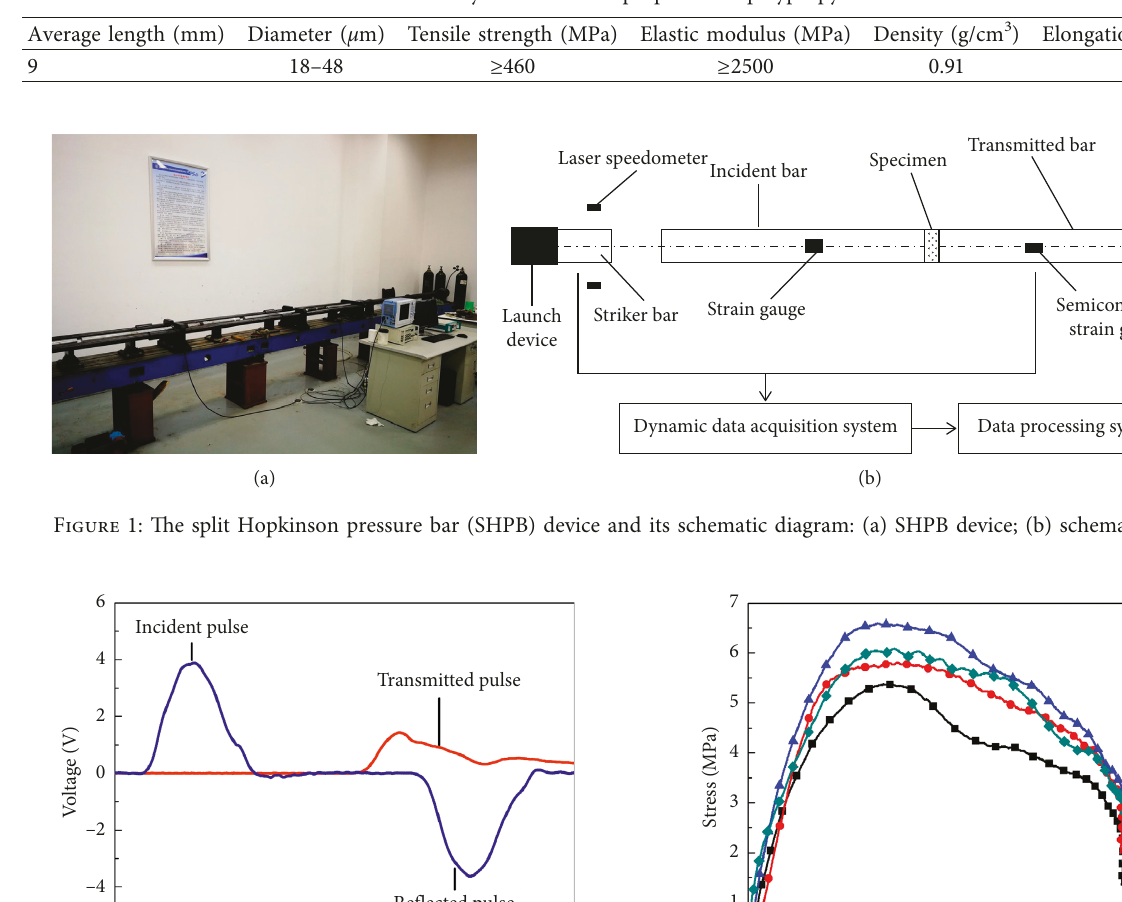
Table 3: Physic-mechanical properties of polypropylene fiber.